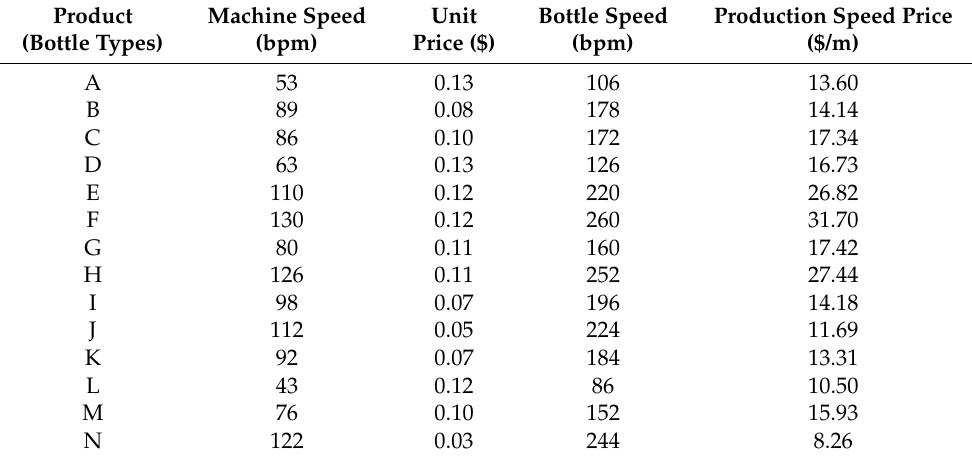
Table 4. Cost analysis of